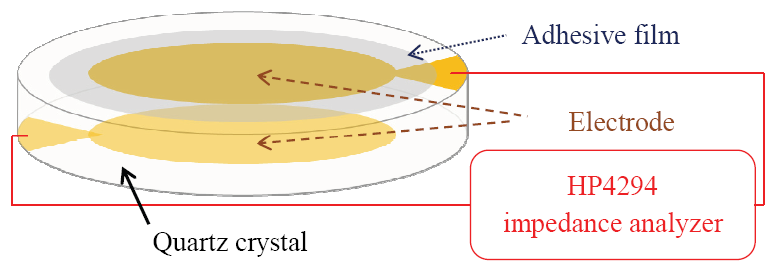
Figure 3. Schematic of a QCM sensor coated with hygrogel adhesive film and the frequency measurement with an HP4294 impedance analyzer. The HP4294 impedance analyzer will send a stable voltage under different frequencies to make the quartz crystal oscillate. The impedance at different frequencies is then measured.